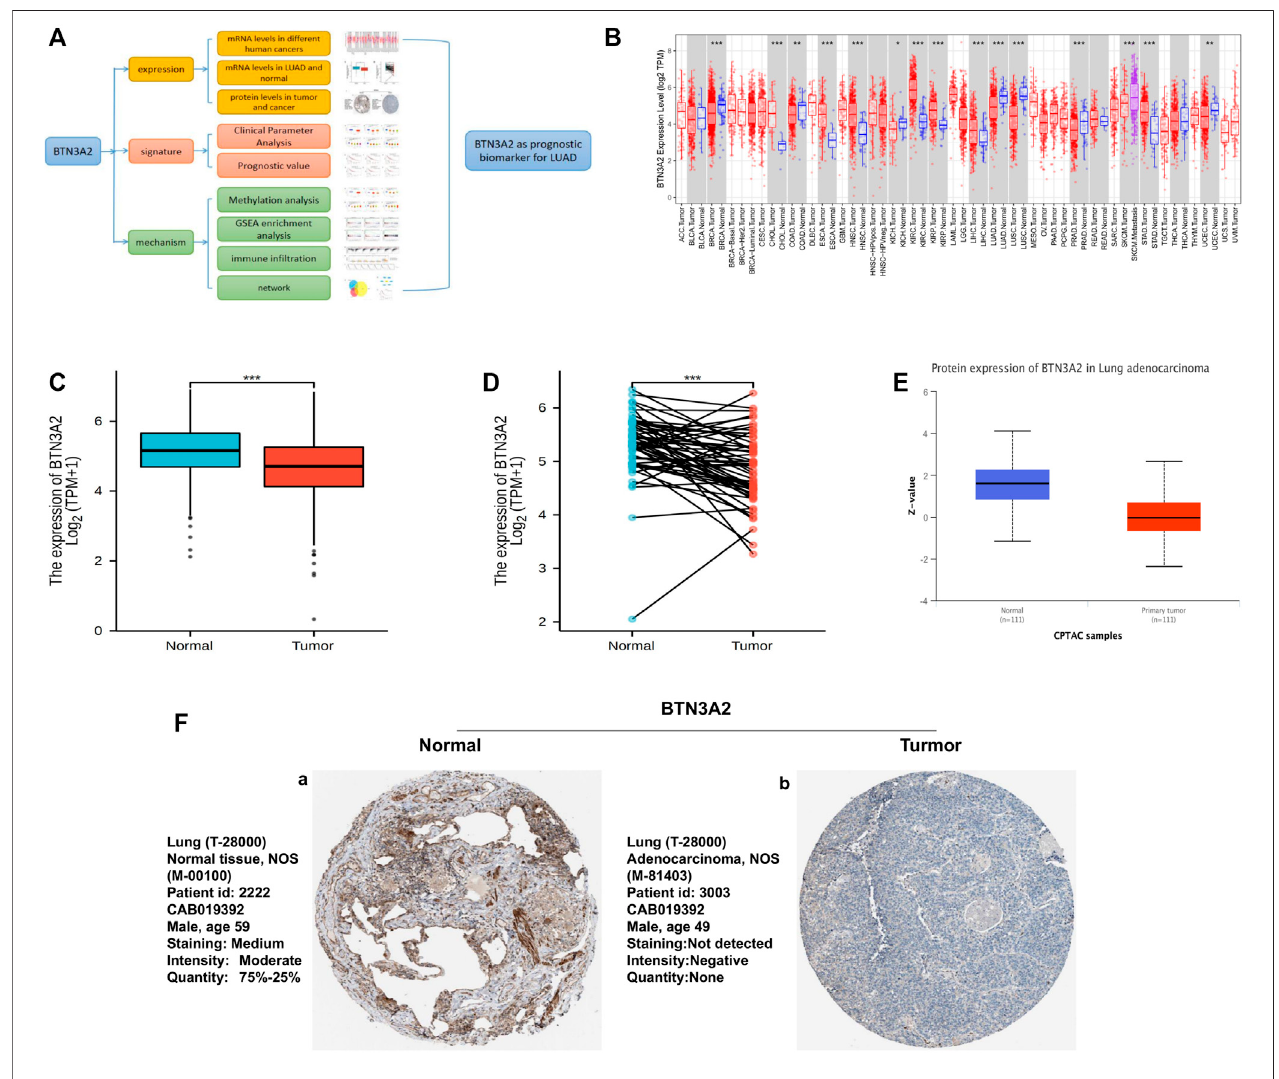
FIGURE1| BTN3A2contentsinvarioushumancancersandLUAD. (A) Work fl owofthisstudy. (B) BTN3A2contentsindifferentcancersfromTCGAdataresource were analyzed by TIMER. (C) BTN3A2 contents in non-malignant and tumor tissues of LUAD patients in the TCGA database. (D) BTN3A2 contents in pre-disease and post-disease form the same sample. (E) UALCAN database showed the protein expression of BTN3A2 in non-malignant and LUAD groups from CPTAC samples. (F) Expression of BTN3A2 in LUAD samples and normal tissues in the Human Protein Atlas.